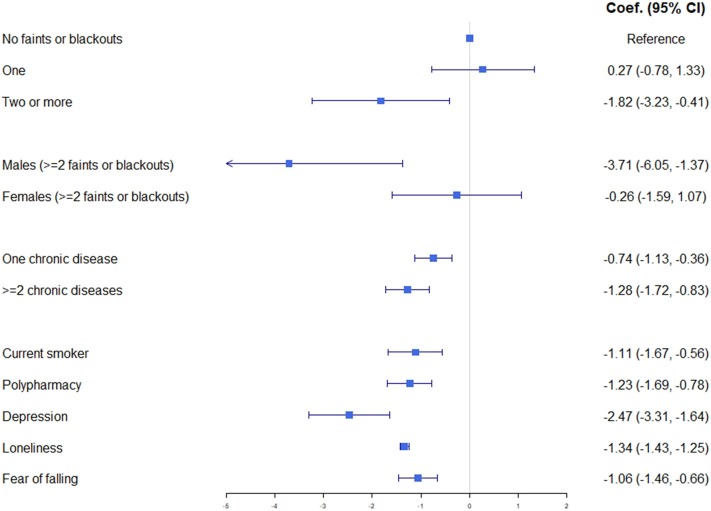
Graphical summary of weighted linear regression Model 3R with coefficient and 95% confidence intervals including those for selected significant covariates for comparison.